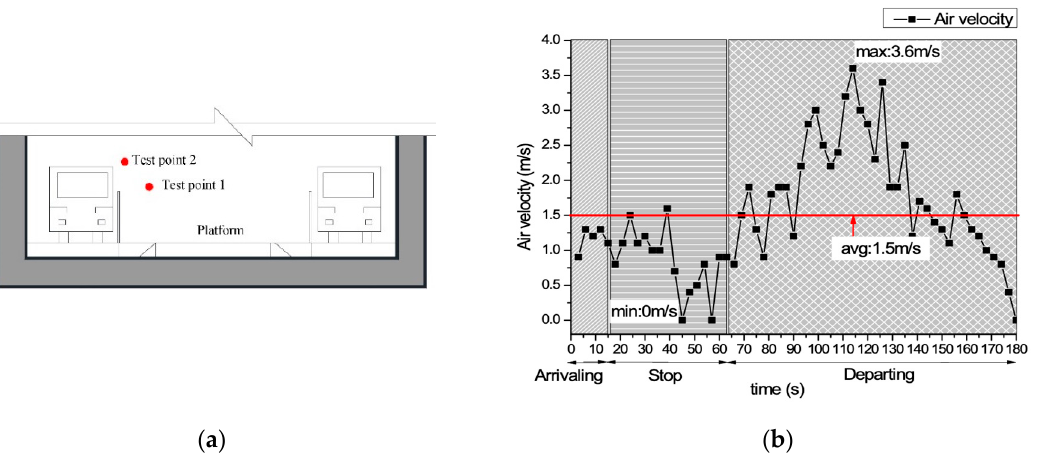
Figure 14. Wind speed curve for one operating cycle of a train. ( a ) Test point location; ( b ) Curve line. Table 10. Questionnaire for the occupancy satisfaction